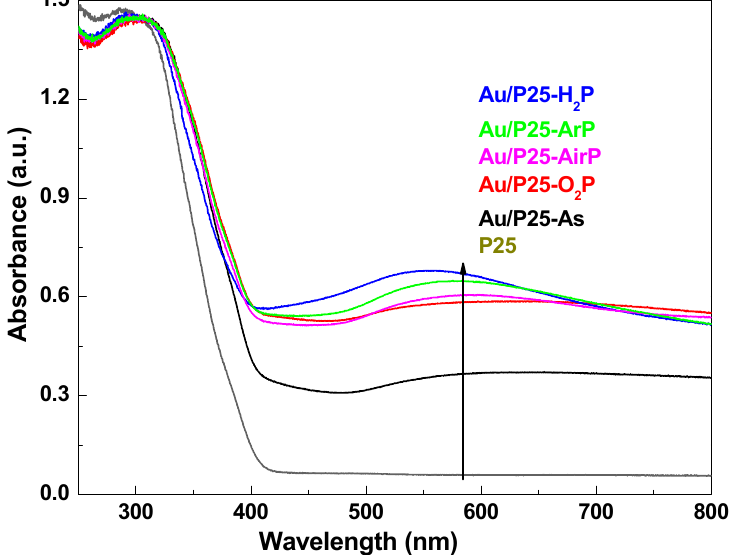
Figure 4. UV-Vis diffuse reflectance spectroscopy (DRS) spectra of the Au/P25 catalysts as prepared and activated by AP cold plasma using various working gases, as well as P25 support.